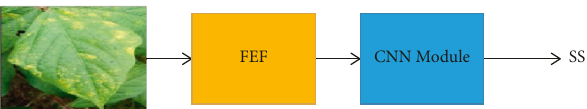
Figure 3: SLS-based leaf disease identification